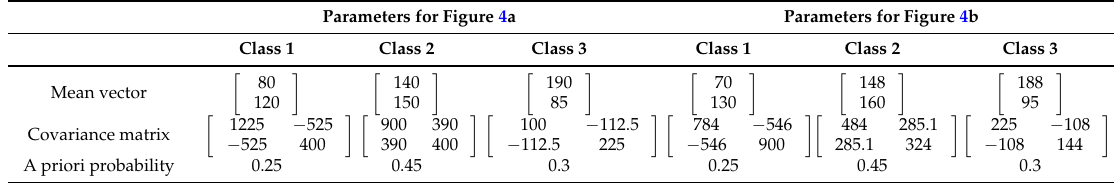
Table 2. Parameters of the bivariate Gaussian distributions of the individual classes in Figure